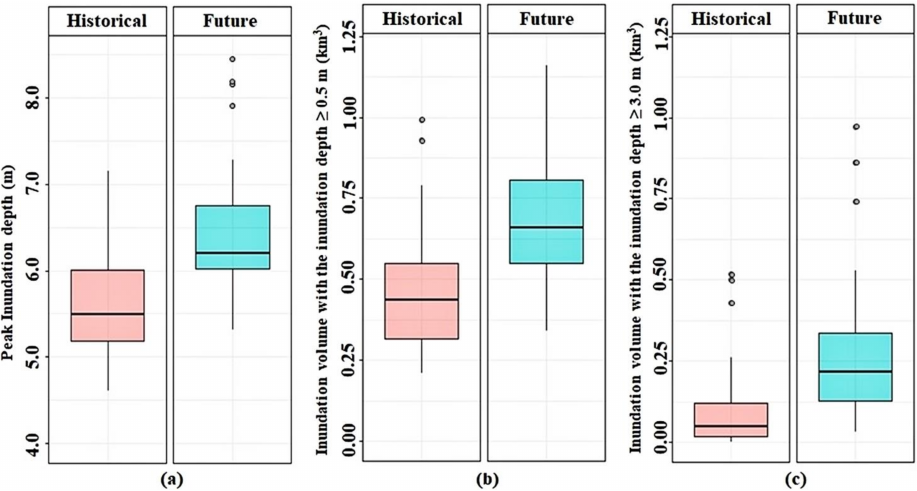
Figure 7. Boxplots of ( a ) peak inundation depths, ( b ) inundation volumes with inundation depth ≥ 0.5 m, and ( c ) inundation volumes with inundation depth ≥ 3.0 m for the top 20 past and top 36 future rainfall events in the